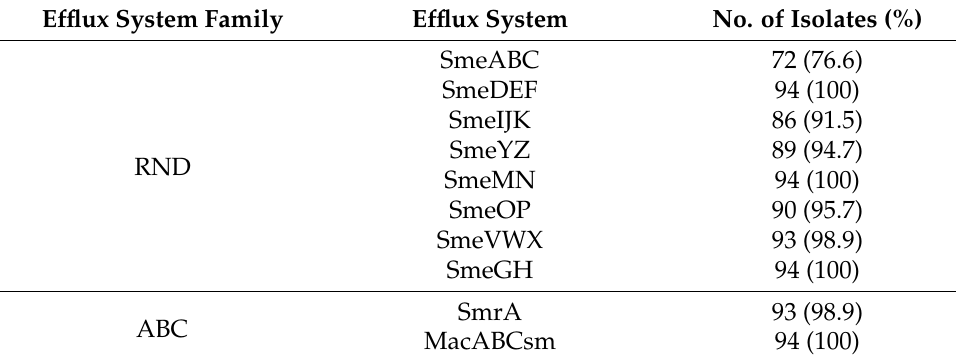
Table 3. The occurrence of MDR efflux systems in S. maltophilia clinical isolates ( n =